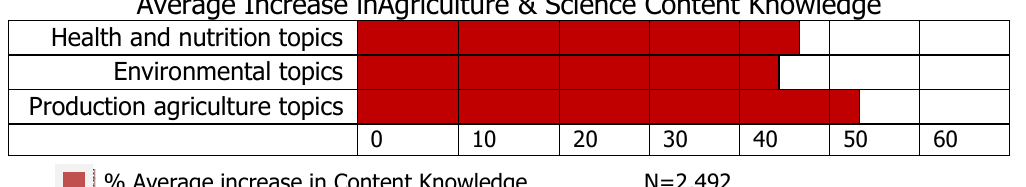
Average Increase inAgriculture & Science Content